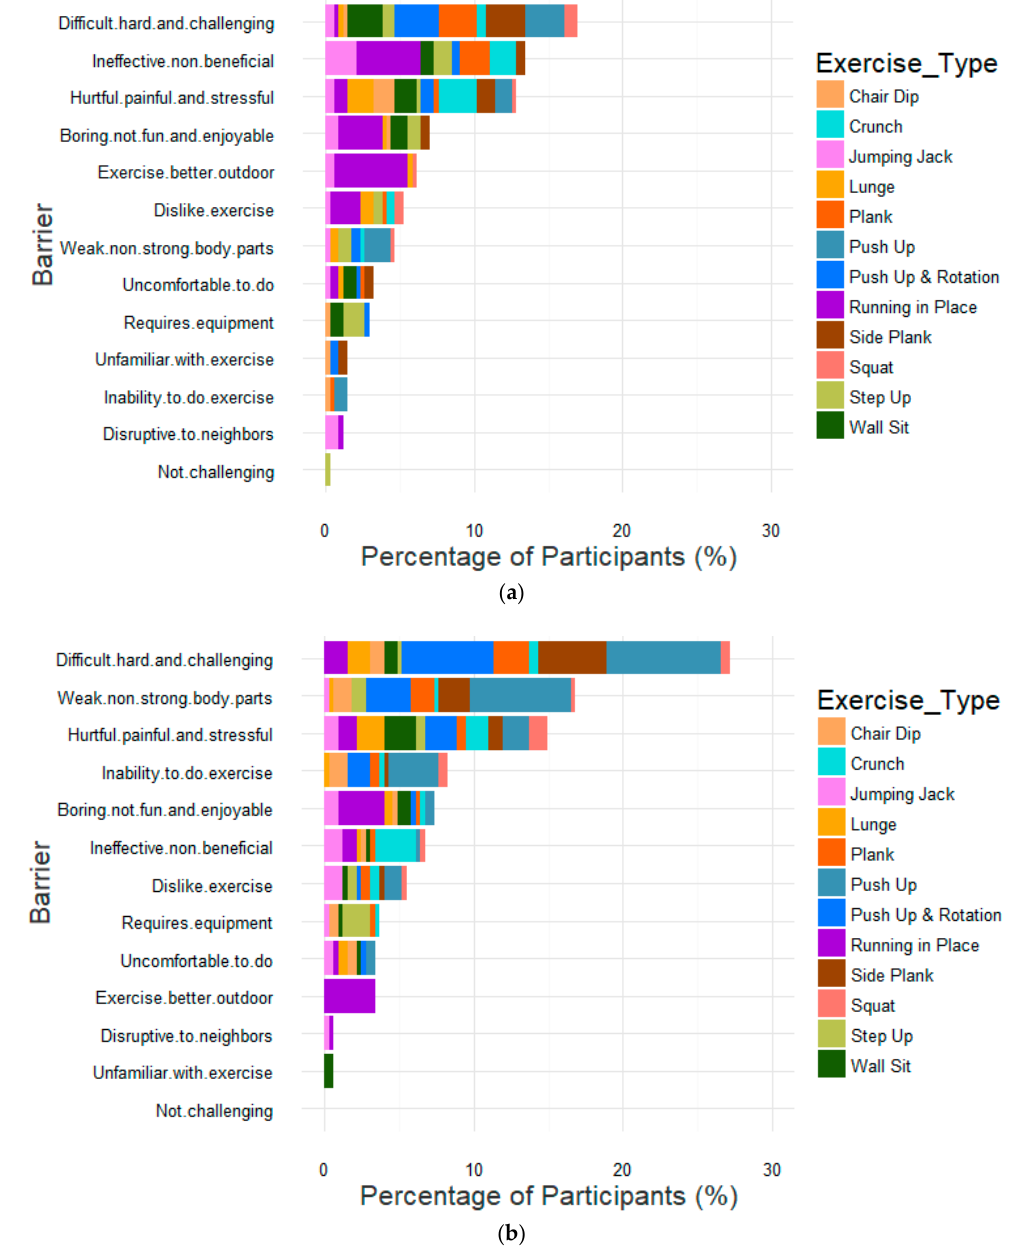
Figure 5. ( a ) Barriers against males’ least preferred exercise types. ( b ) Barriers against females’ least preferred exercise types.